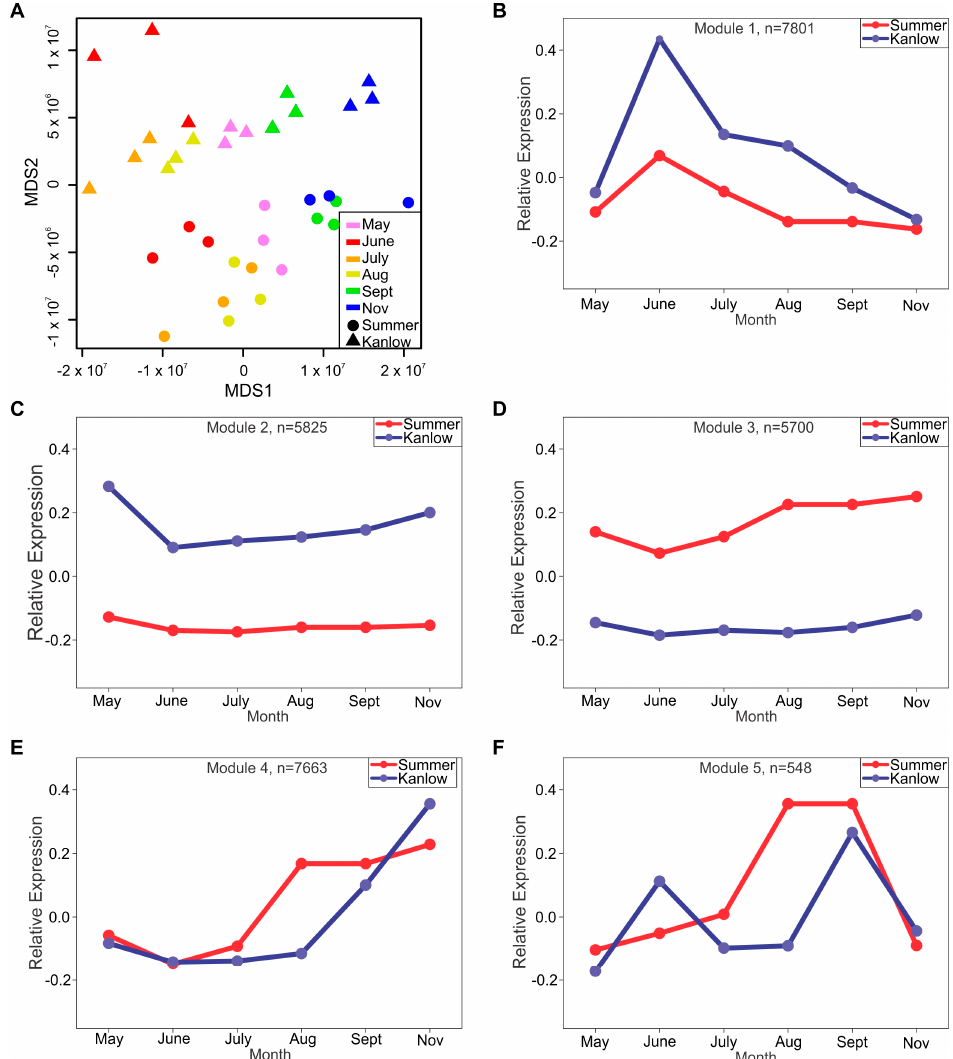
Figure 5. Global gene expression analysis in switchgrass rhizomes. ( A ) MDS plot of transcriptomes for every biological replicate at each sampling date for Kanlow ( ▲ ) and Summer ( ● ) rhizomes. Colors are as described in Figure 4A. ( B ) Network analysis of transcriptomic data. ( C – F ) Expression profiles for modules (1–5) described in the text are shown. Kanlow (blue lines) and Summer (red lines) at each sampling date. Full results from network analyses are given in Supplementary Data S1.